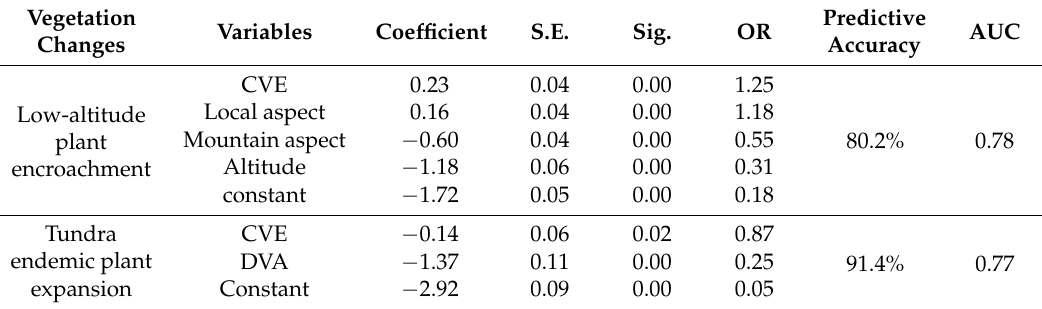
Table 3. The results of binary logistic regression.